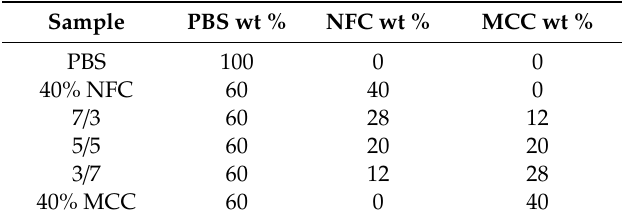
Table 1. The prepared poly (butylene succinate) (PBS) / cellulose